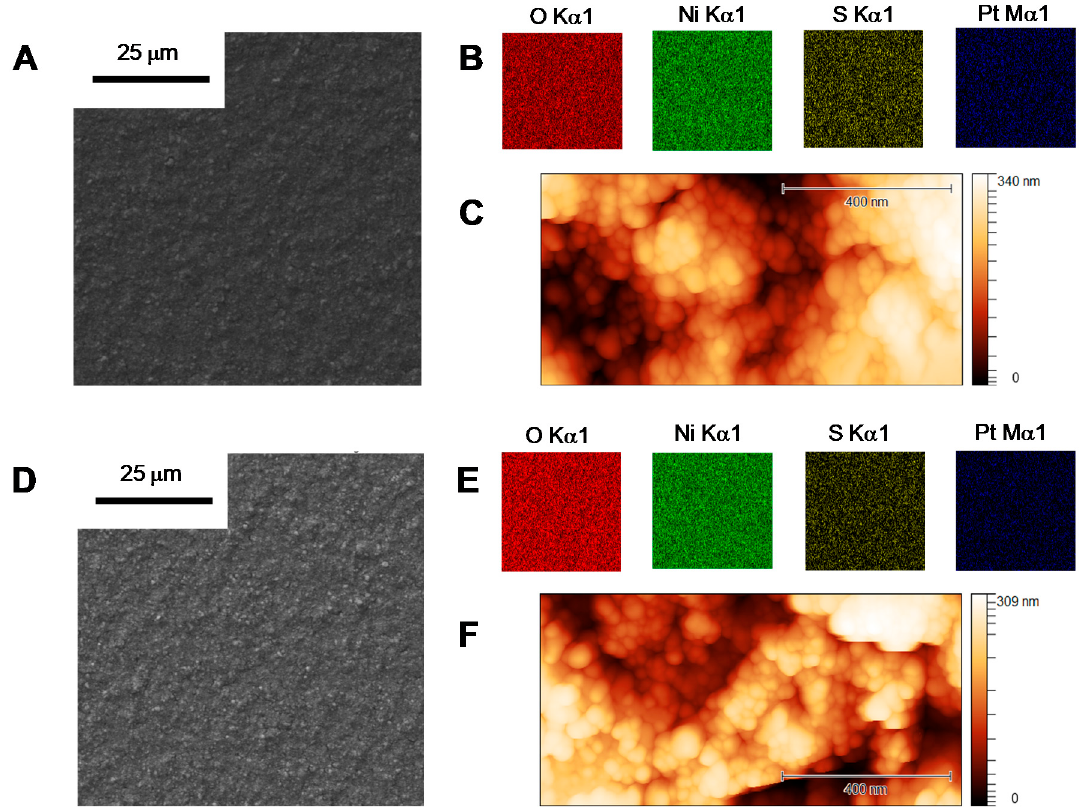
Figure 3. SEM micrographs ( A , D ), corresponding EDS elemental maps ( B , E ), and AFM images ( C , F ) of sensitized NiO electrodes of type A after Pt deposition using Method 1 at 20 s deposition time ( A – C ) and Method 5 ( D – F ).